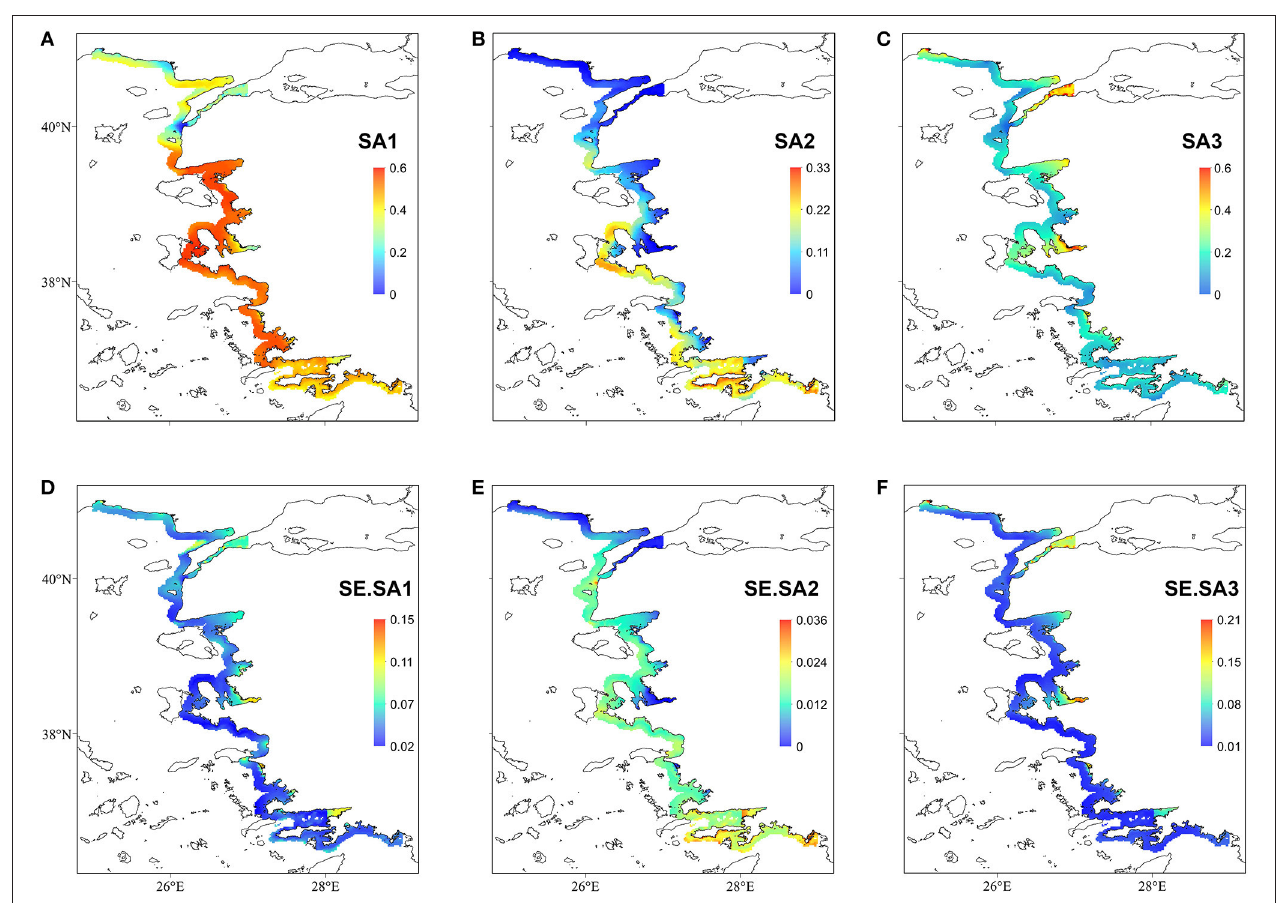
FIGURE 4 | Top panel: Probability of occurrence of the three Species Archetypes (A) SA1; (B) SA2; (C) SA3. Bottom panel: prediction standard errors (D) SE.SA1; (E) SE.SA2; (F) SE.SA3. Notice the different scale bars in each